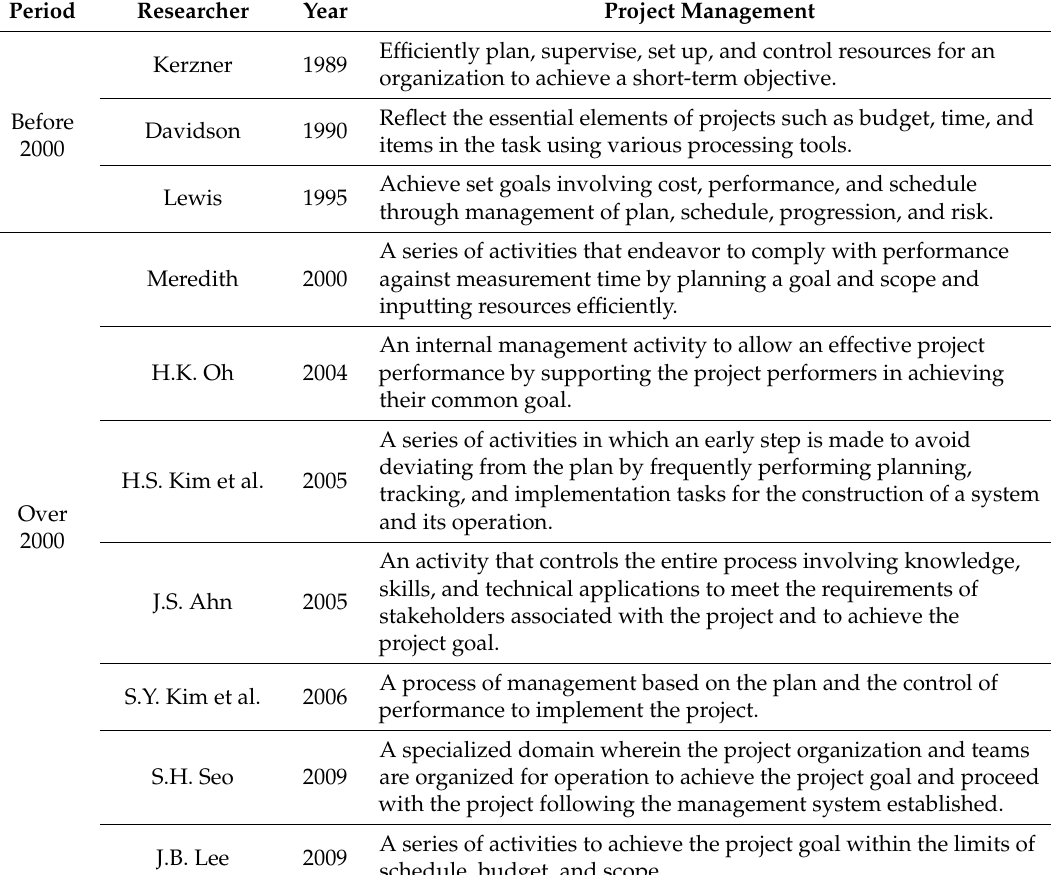
Table 3. Project